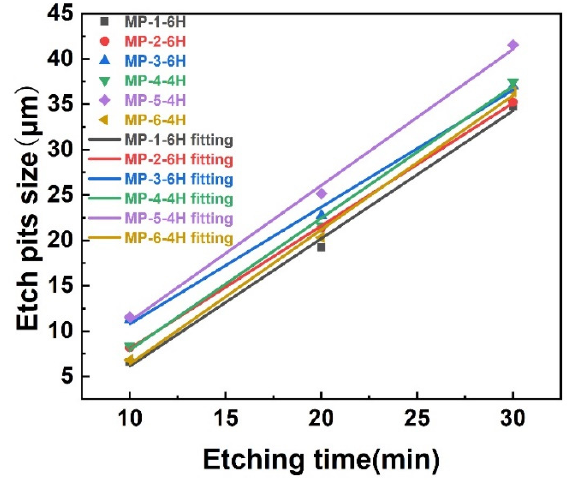
Figure 2. Etch pits size of micropipes vs. etching time.